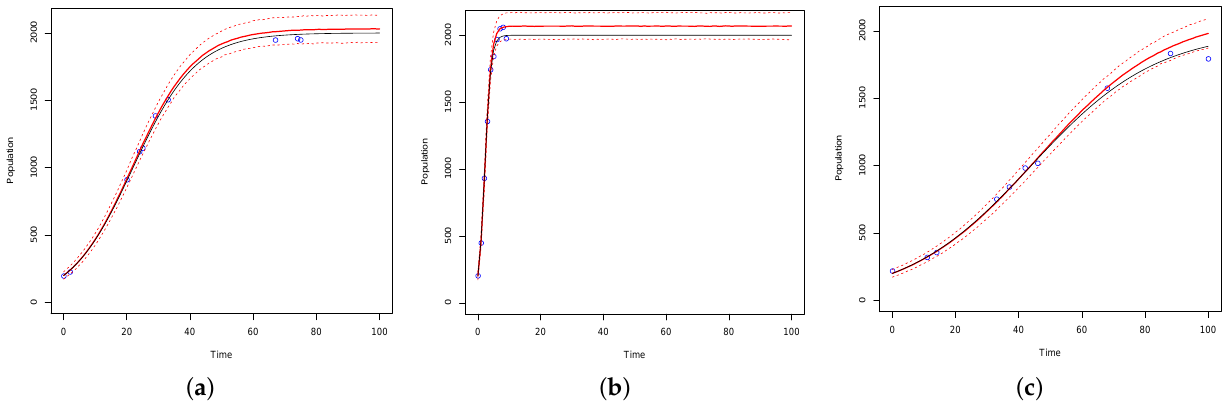
Figure 5. 10,000 MCMC samples are used to simulate D Φ —optimal designs for ( a ) normal, ( b ) fast and ( c ) slow growth models. All models are simulated across 100 time points with a carrying capacity of 2000. The ground truth models are plotted in black. The optimal design points are plotted in blue and fit by a solid red curve, where the 2.5% and 97.5% quantiles of the predicted values are plotted as red dotted lines.